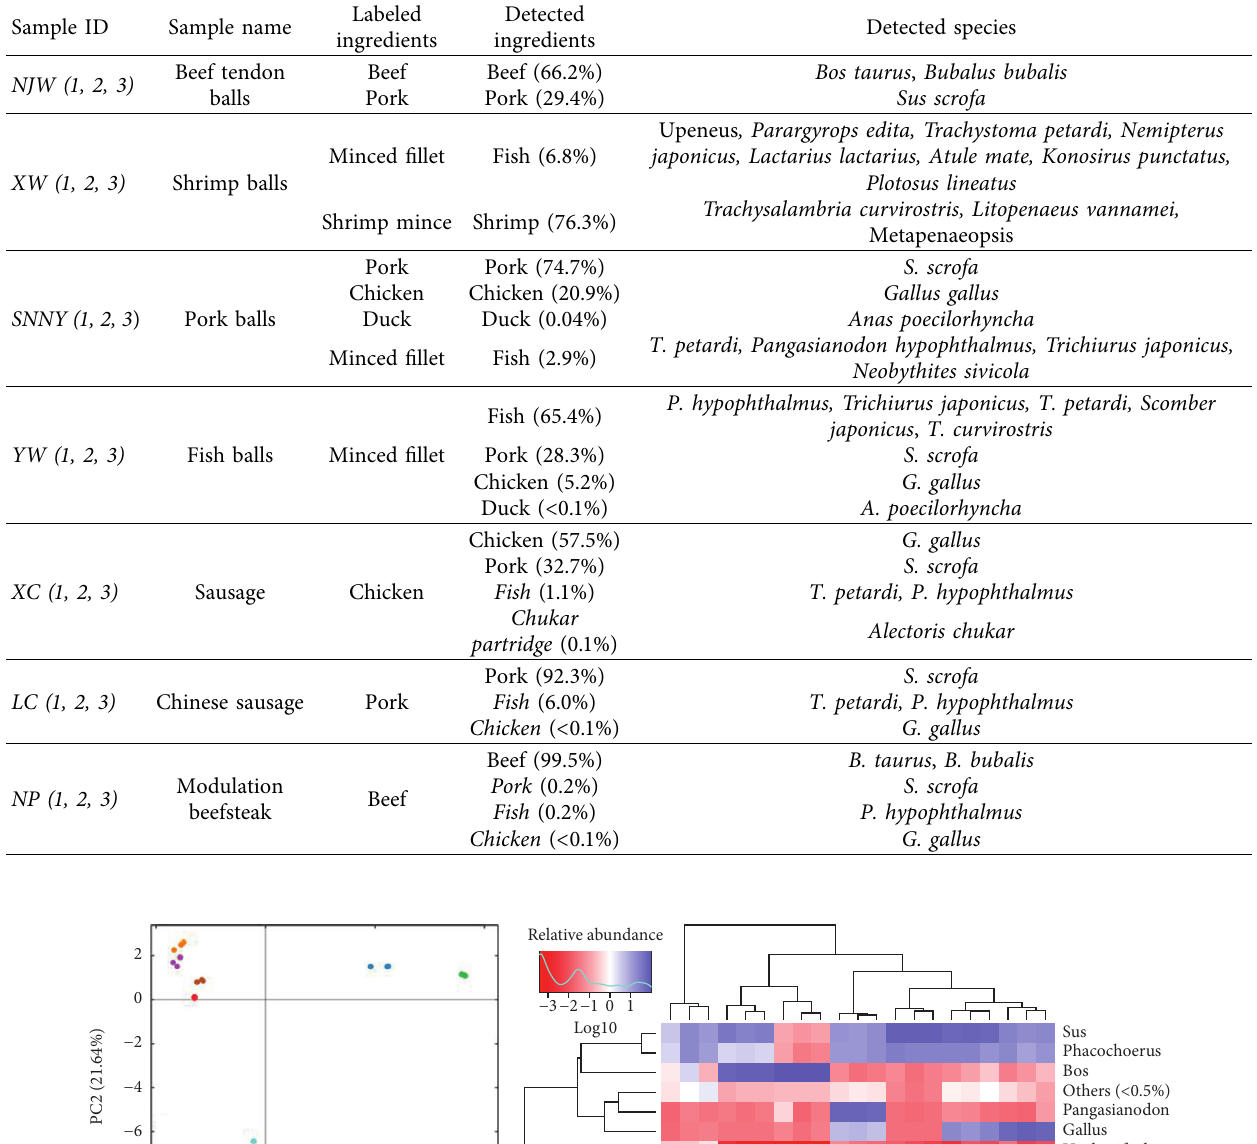
Table 3: The detected ingredients and the labeled ingredients of the seven commercial samples.